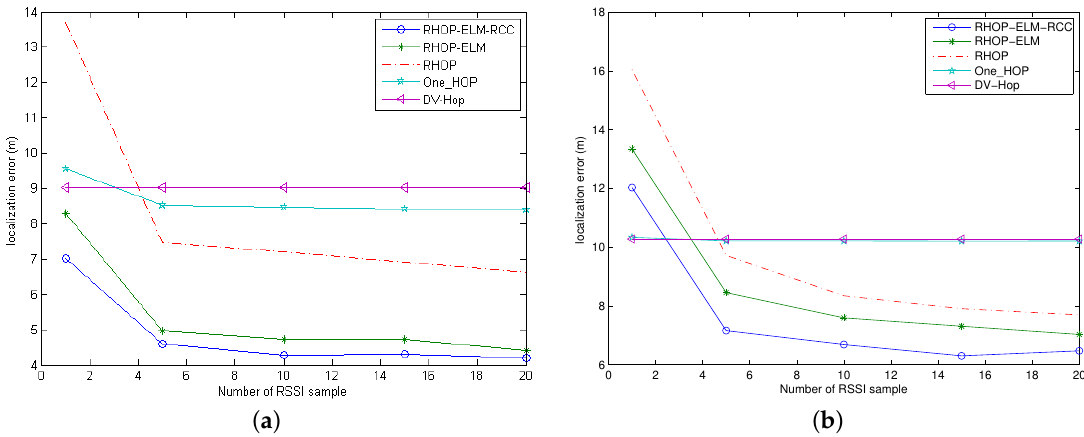
Figure 6. Localization errors against the amount of RSSI samples. ( a ) The case with 50 nodes in the area of 50 m × 50 m; ( b ) The case with 100 nodes in the area of 100 m × 100 m.